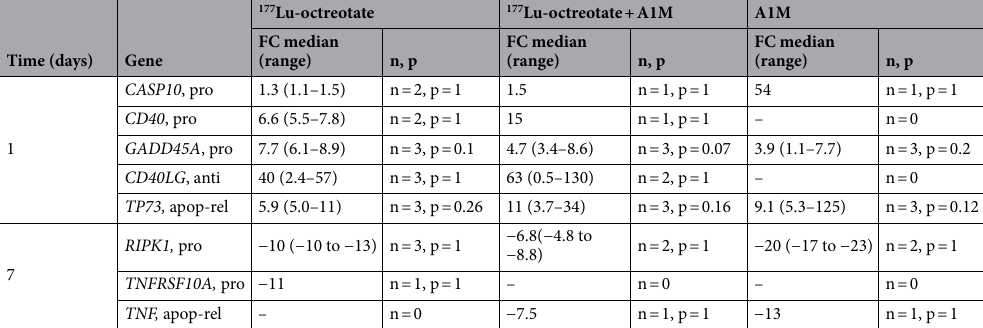
Table 2. Genes with high FC > 7 in at least one group at 1 and 7 days after injection that were not statistically significant expressed compared to corresponding controls. Expression is given as median FC (range), n is the number of data points, and the p-value is given from statistical analysis versus corresponding controls. Pro, anti and apop-rel are abbreviations of pro-apoptotic, anti-apoptotic and apoptosis-related, respectively. Statistical analyses were performed using Perseus software 1.6.15.0 (https:// maxqu ant. net/ perse us/).